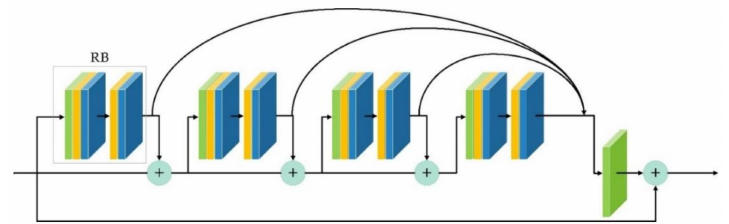
Figure 2. A super-resolution pipeline using Residual Feature Aggregation (RFA) blocks. Color coding is the same as Figure 1. The outputs of all RB (shown in the grey box) are aggregated at the output using a 1 × 1 convolution